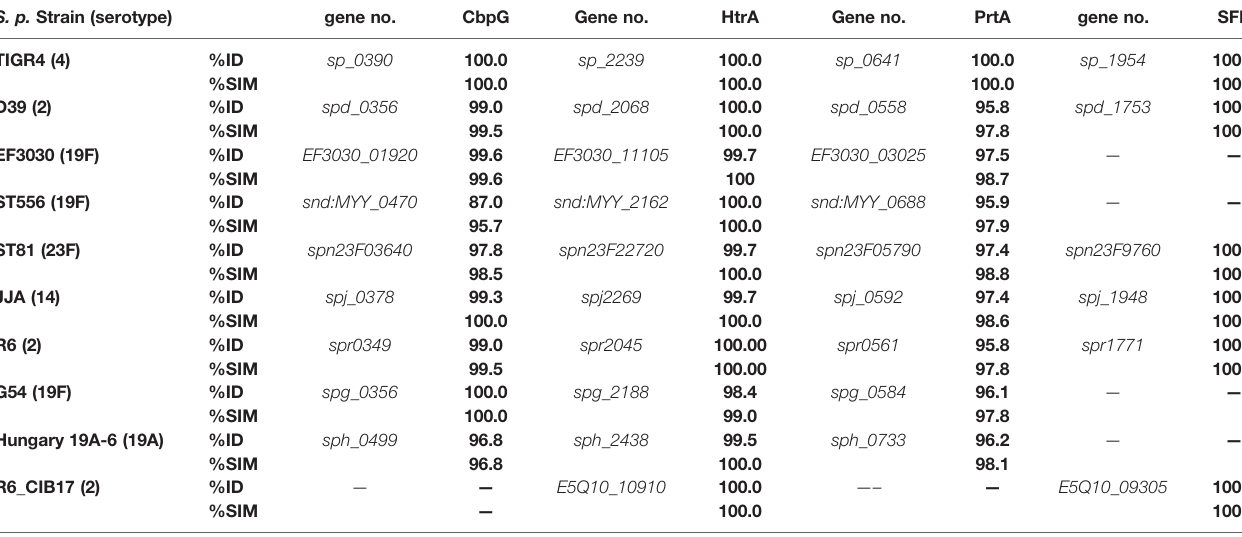
TABLE 1 | Protein sequence homology [%] of serine proteases among different selected pneumococcal strains based on protein sequences from S. pneumoniae TIGR4 (Tettelin et al., 2001), and D39 for SFP. S. p. Strain